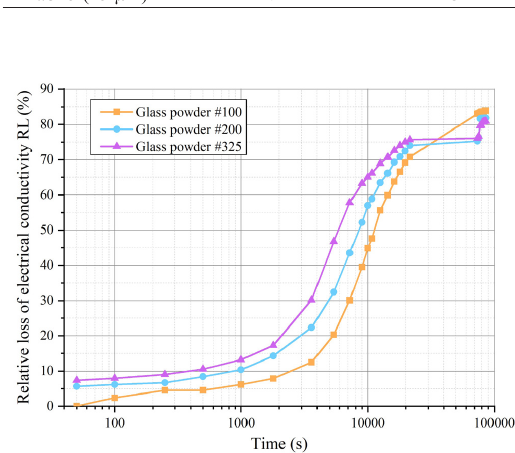
Figure 10. Relative loss of electrical conductivity over time (s) for CH and glass powder solutions in the three particle sizes